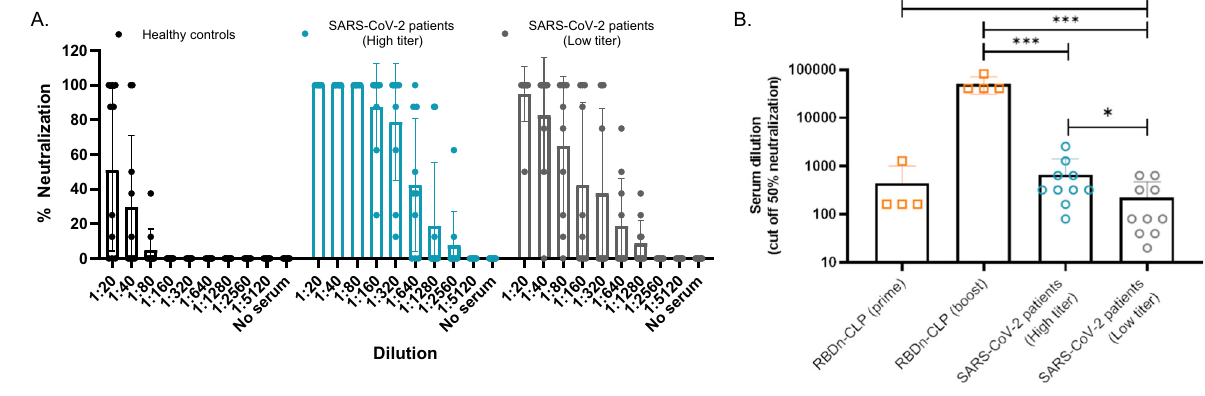
Fig. 6 Neutralization capacity of serum from convalescent SARS-CoV-2 patients, performed at Aarhus University. a A dilution series of individual human plasma samples from SARS-CoV-2 patients (with either high ( n = 5) or low ( n = 5) ELISA binding titers against recombinant SARS-CoV-2 spike protein) or healthy controls ( n = 5) were mixed with a clinical SARS-CoV-2 isolate and tested for cell entry. Each dot represents the percentage neutralization per sample, per dilution. Bars represent the mean of the group with a standard deviation. b Endpoint serum dilution required for 50% virus neutralization. Each dot represents the serum dilution needed for 50% virus neutralization according to the dilution titration of the sera in the neutralization assay (Fig. 6a and Fig. 5b, c). Bars represent the mean of the group with a standard deviation. One sided non-parametric Mann-Whitney test was used for statistical comparison. Statistically signi fi cant differences are marked by asterisk: ns = non-signi fi cant, *: p < 0.05**: p ≤ 0.005, ***: p ≤ 0.001. Speci fi cally, *** (RBDn-CLP(boost) vs SARS-Cov-2 patients (high titer)) p = 0.001; *** (RBDn-CLP(boost) vs SARS-Cov-2 patients (low titer)) p = 0.001; * (SARS-Cov- 2 patients (high titer) vs SARS-Cov-2 patients (low titer)) p =